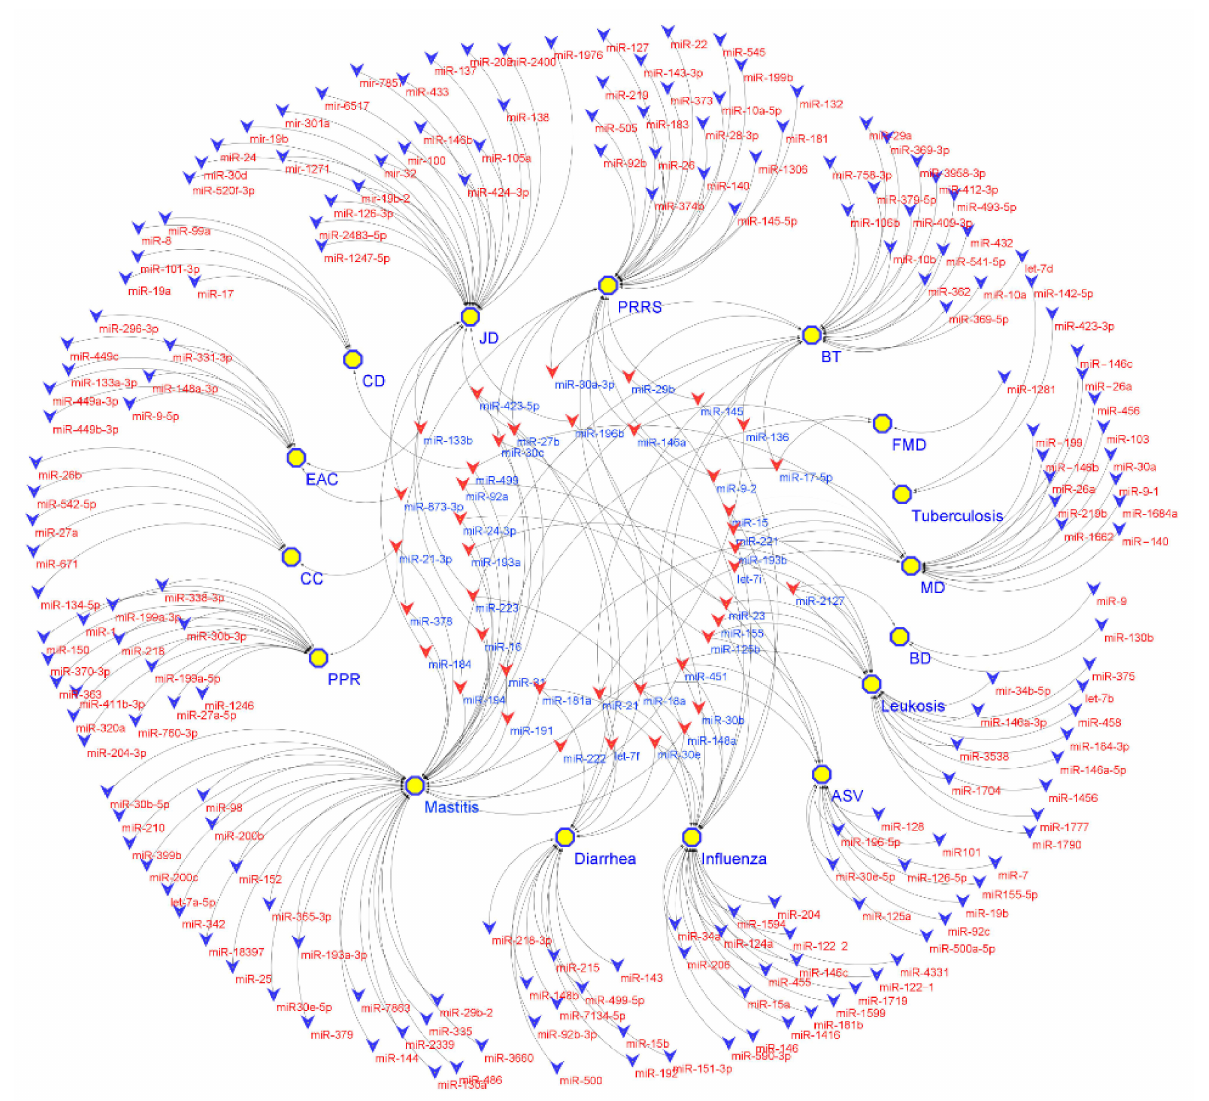
Figure 2. miRNAs in livestock diseases. Each V node represents an miRNA (blue V nodes (outer circle) represent miRNAs associated to one disease, and red V nodes (inner circle) present miRNAs associated to more than one disease) and each yellow hexagon node represents a livestock disease. FDM: foot and mouth disease; PRRS: porcine reproductive and respiratory syndrome; ASV: African swine fever virus; MD: Marek’s disease; BD: bursal disease; CD: chronic respiratory diseases; PPR: Peste des petits ruminants; CC: Cystic echinococcosis; EAC: enzootic nasal adenocarcinoma; BT: bluetongue; JD: Johne’s